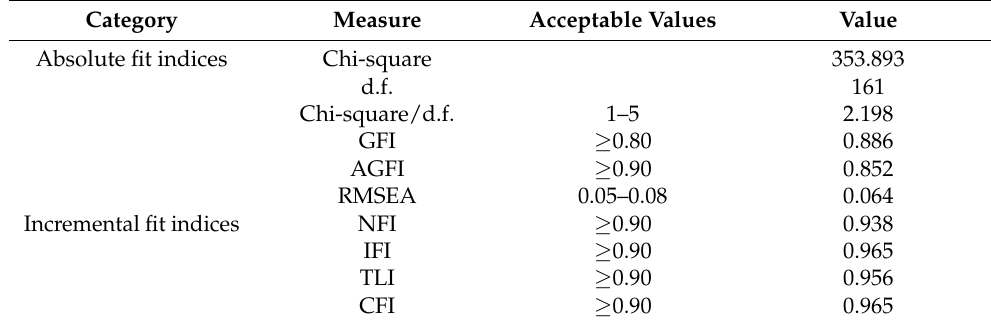
Table 5. The goodness of fit for the model.